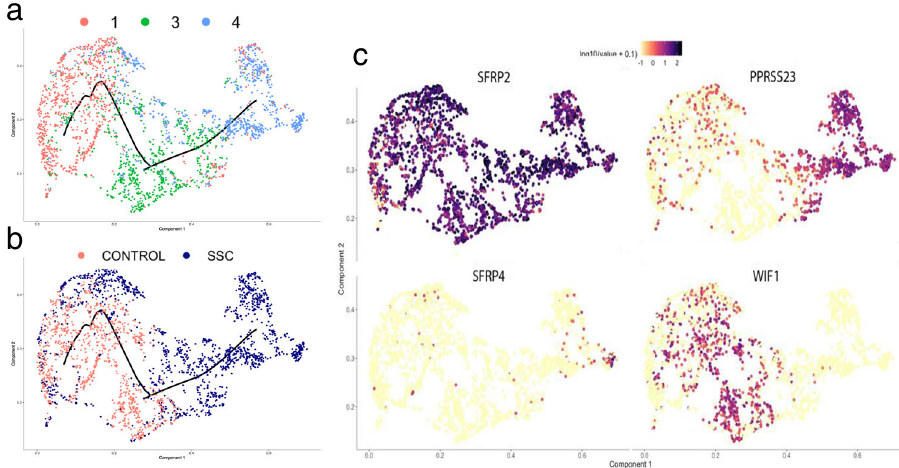
Fig. 5 Pseudotime modeling of SFRP2 + fi broblast differentiation in SSc skin. Fibroblast subclusters de fi ned in Fig. 2 were analyzed using Monocle with the trajectory as indicated by the black line, with cells colored by subcluster of origin: subclsuter 1 (red), subcluster 3 (green), and subcluster 4 (blue; a ) or by subject status: healthy control (red) and SSc (blue; b ). SFRP2 was expressed by all of the cells ( c , right lower panel). PRSS23 was expressed more highly by cells clustered later in pseudotime, corresponding to fi broblast subcluster 4 ( c ). SFRP4 was expressed more highly expressed even later in pseudotime, corresponding to myo fi broblasts identi fi ed in t -SNE plots (Figs. 3a and